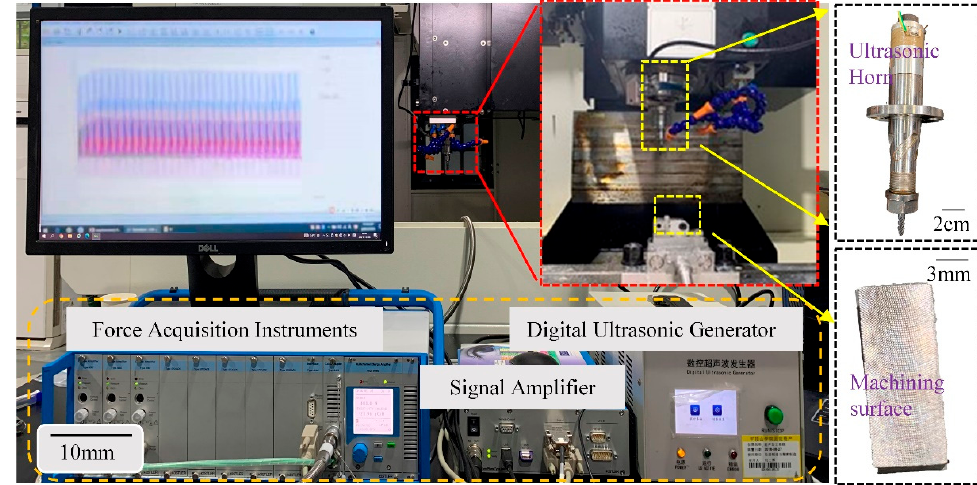
Figure 1. Longitudinal torsion ultrasonic-assisted milling test set.